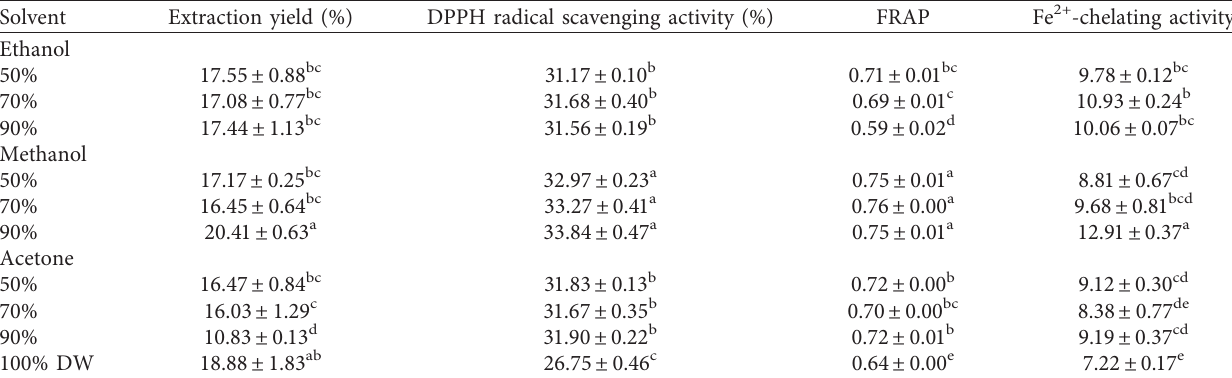
Table 1: Extraction yields and antioxidant activities of olive leaf extracts obtained using various solvents.